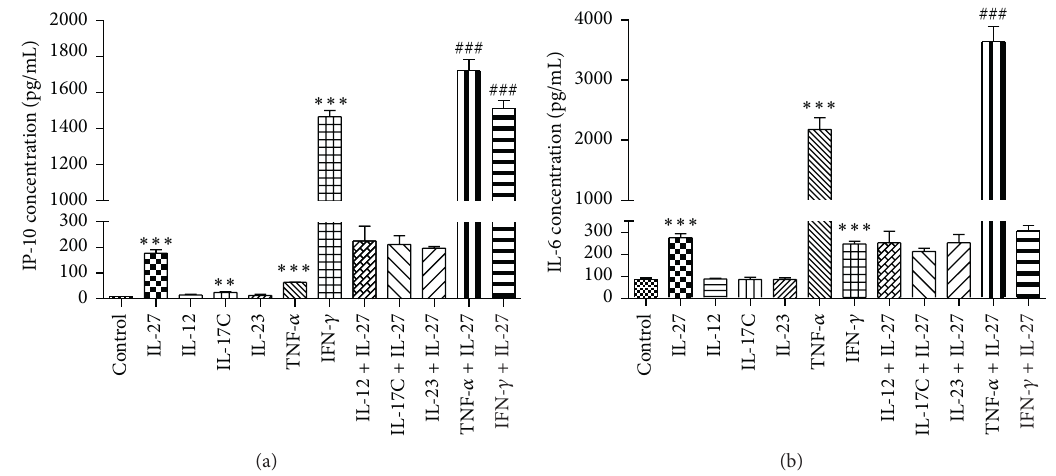
Figure 4: IL-27 and TNF- 𝛼 synergistically potentiated the production of CXCL10 and IL-6 in HTR-8/SVneo. CXCL10 and IL-6 protein levels were detected by ELISA after being stimulated with cytokines. The dose for TNF- 𝛼 and IFN- 𝛾 was 20ng/mL and for other cytokines was 50 ng/mL. Results are expressed as the arithmetic mean plus SD of three independent experiments. ∗∗ 𝑃 < 0.01 and ∗∗∗ 𝑃 < 0.001 when compared between treatment group and control. ### 𝑃 < 0.001 when compared between combined treatment group and IL-27 stimulated group ( 𝑛 = 3 ).